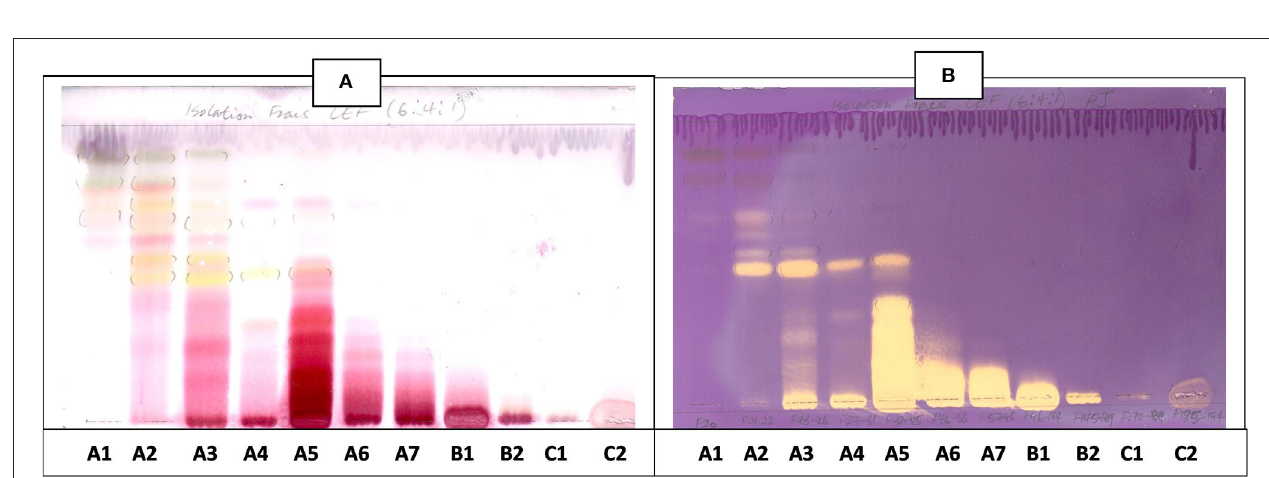
FIGURE 9 | (A) Chromatogram developed in CEF [chloroform: ethyl acetate: formic acid (6:4:1)] of 11 combined fractions obtained from the first column sprayed with vanillin. (B) Antioxidant bioautography–TLC plate developed with CEF (6:4:1) and sprayed with DPPH. Yellowish bands indicate compounds antioxidant activity.